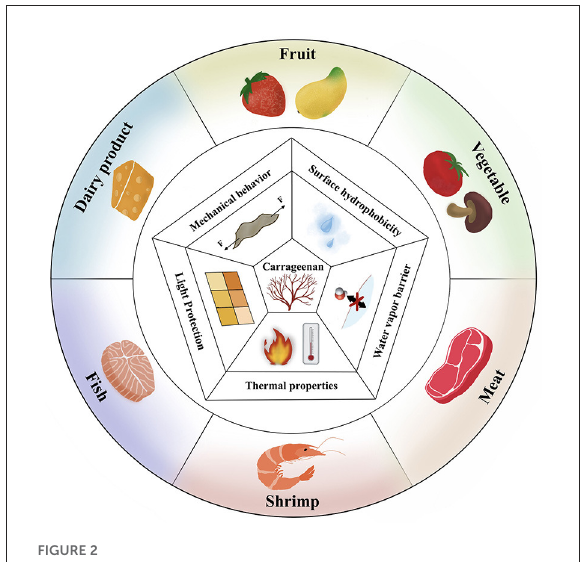
FIGURE2 Properties of the carrageenan-based film and its application in food packaging.